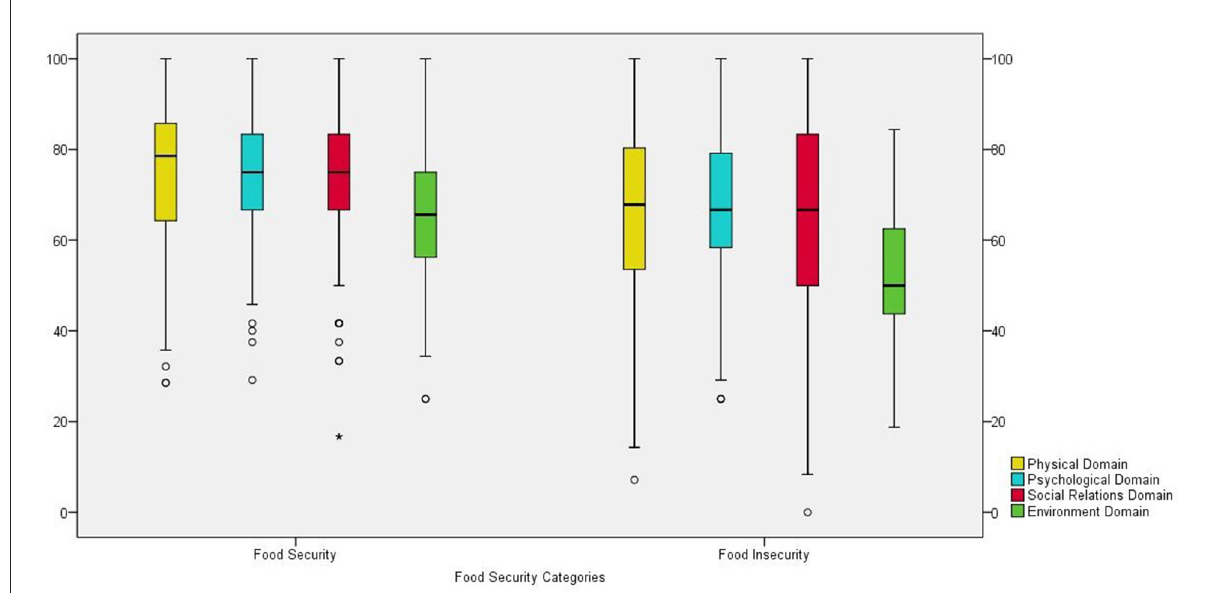
FIGURE1 Boxplot of stratified analysis of groups Food Secure and Food Insecure (Md; IIQ) by scores of the domains of Quality of Life (QoL) of adults and older adults. Study Brazuca Natal ( n =